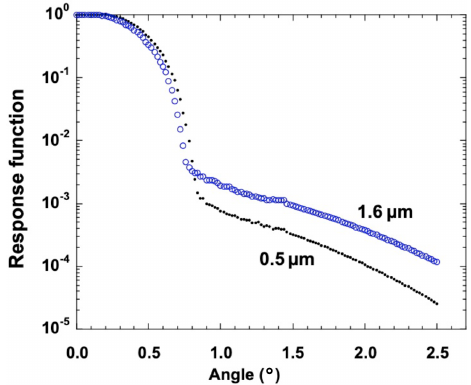
Figure 7. Response functions of the sky radiometer at λ = 0 . 5 and 1.6µm measured by the solar disk scan